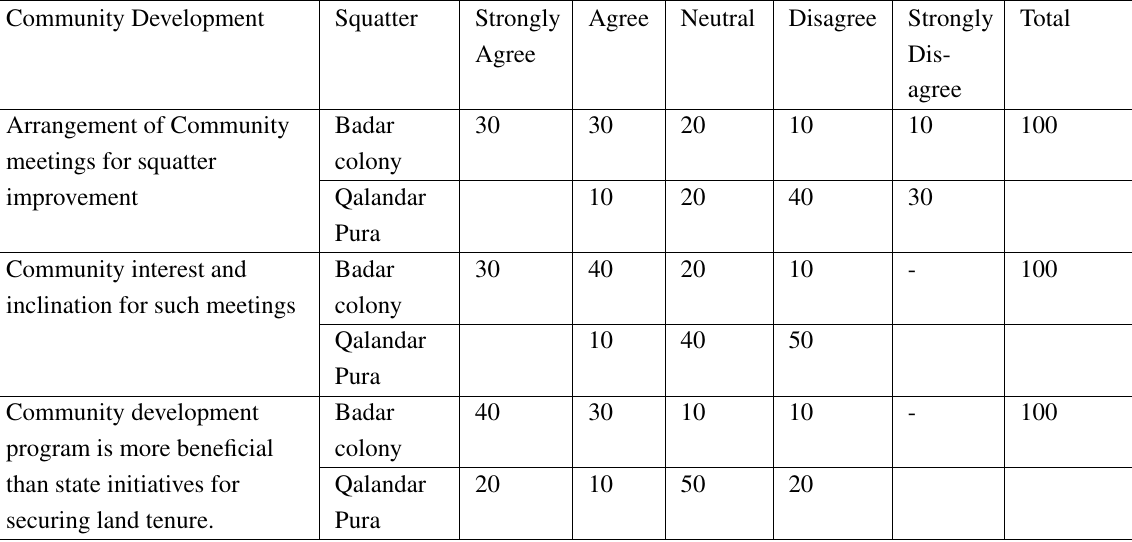
Table 7. Community Development in squatters, Source: